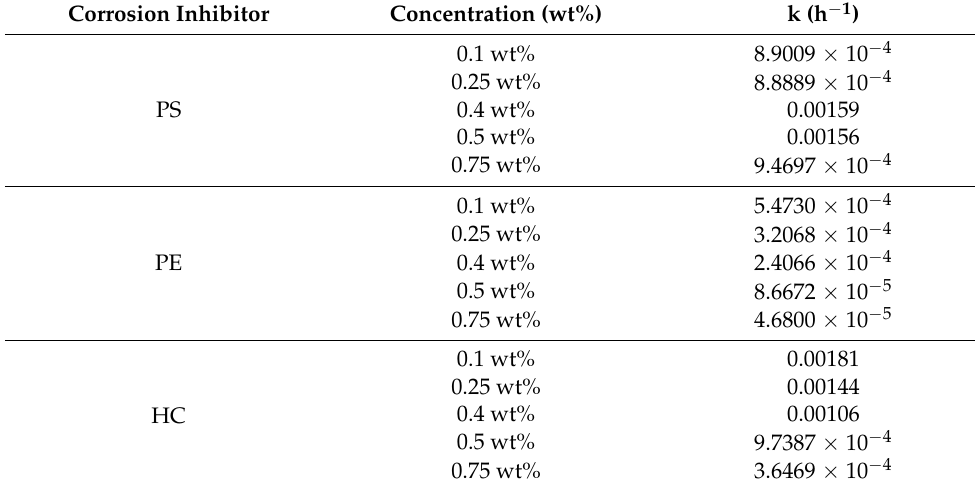
Table 1. Reaction rate